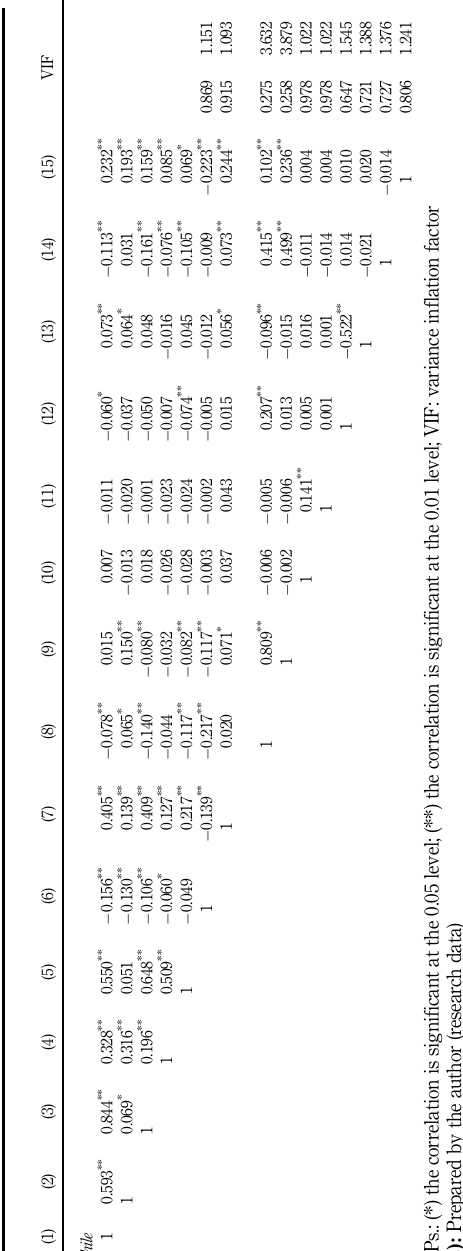
Table 7. Pearson correlation and variance inflation factor